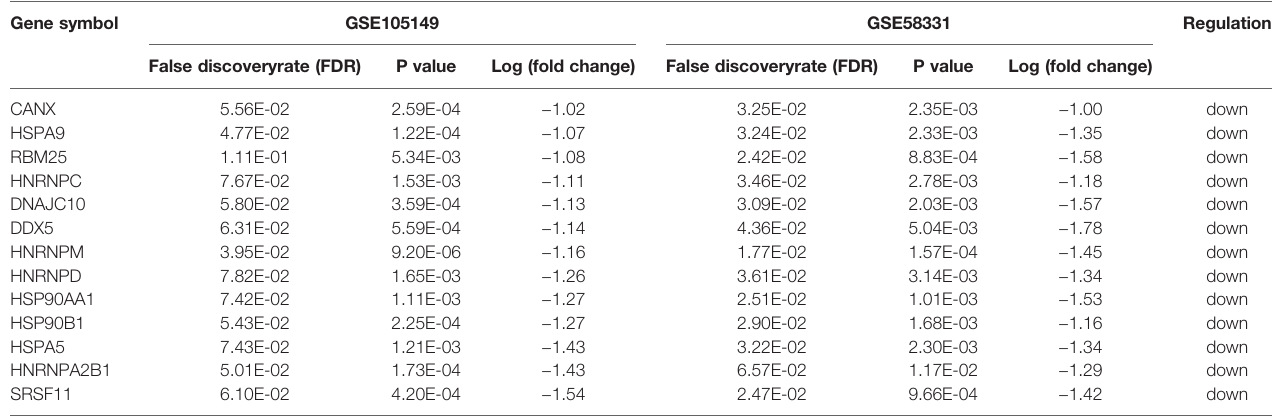
TABLE 1 | The hub genes associated with lacrimal gland enlargement in Graves ’ ophthalmopathy. Gene symbol